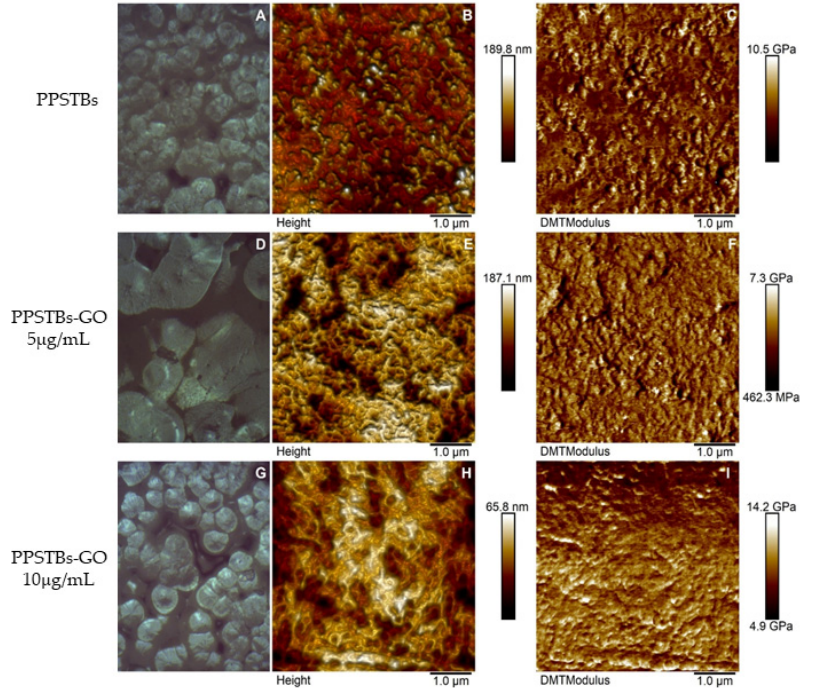
Figure 1. Optical images, AFM micrographs of 2D surface topography, and DMT Modulus channels of PPSTBs ( A – C ), PPSTBs-GO 5 µ g/mL ( D – F ), and PPSTBs-GO 10 µ g/mL ( G – I )